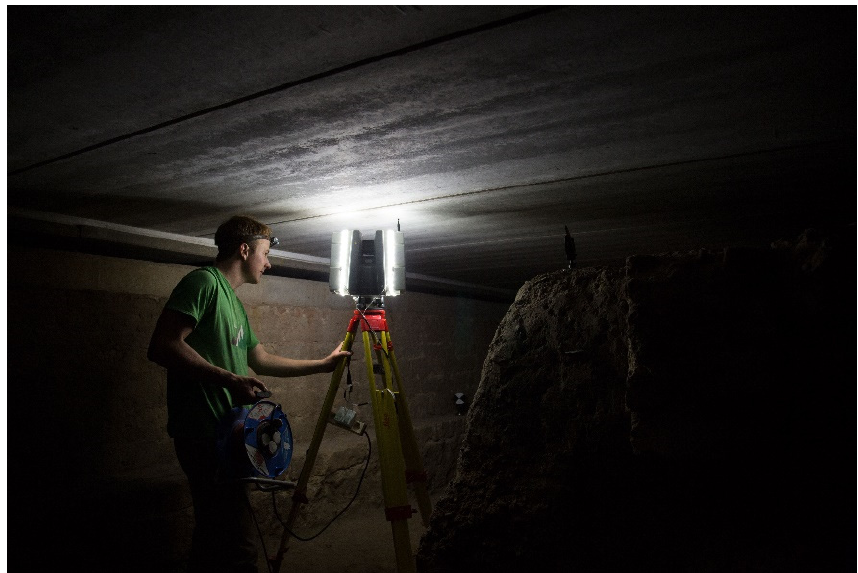
Figure 25. On ‐ site acquisition with an adapted system to reduce problems in low ‐ light conditions. Figure 25. On-site acquisition with an adapted system to reduce problems in low-light